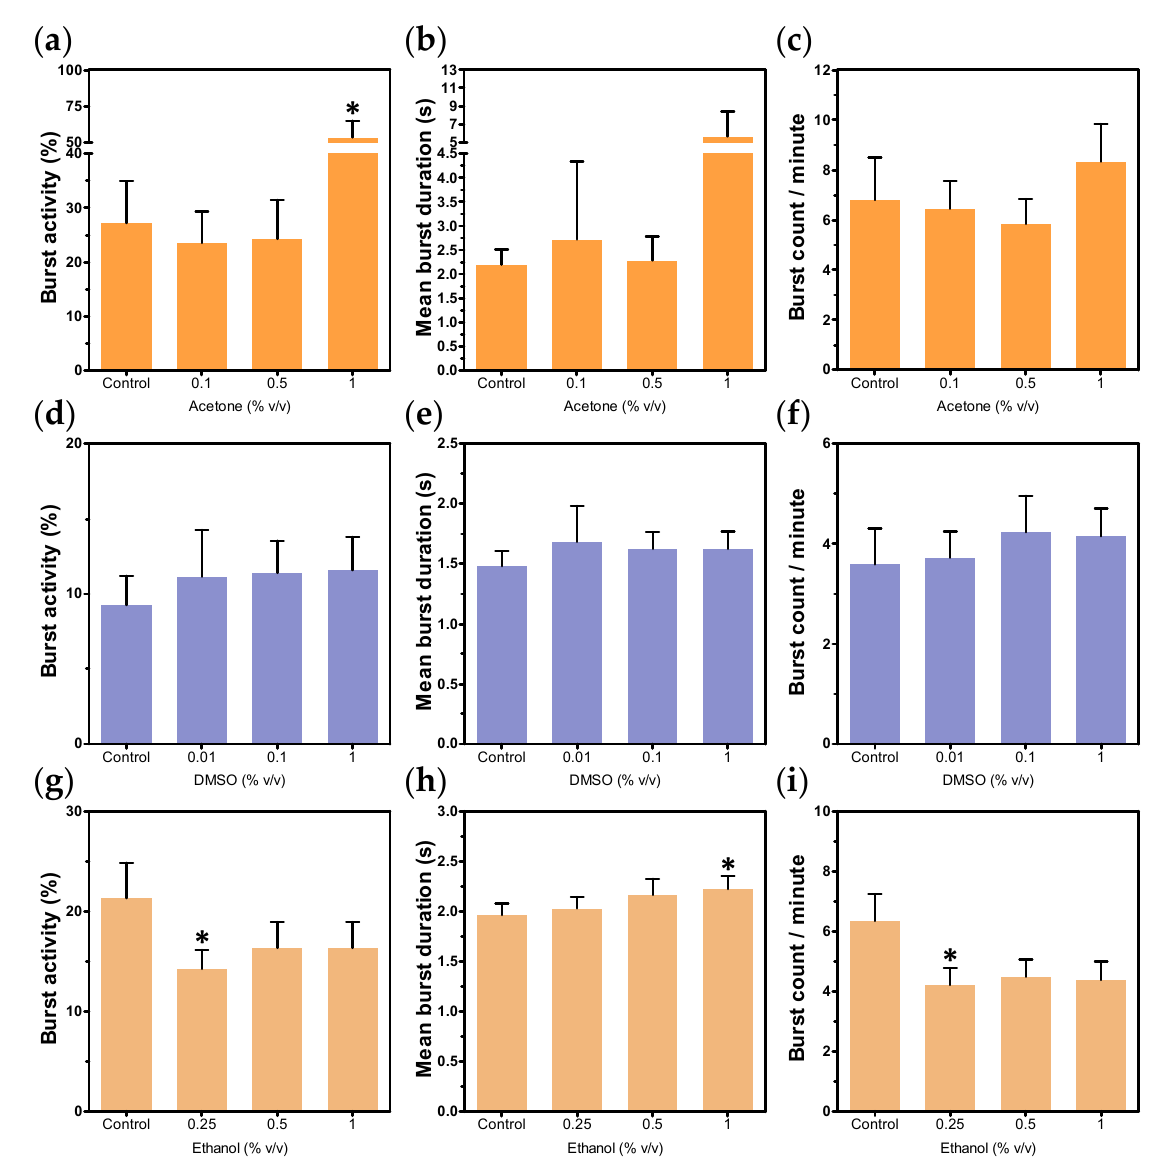
Figure 6. Coiling activity of zebrafish ( Danio rerio ) embryos aged 26.0–28.5 h post-fertilization (hpf) following exposure to organic solvents. ( a – c ) Acetone; ( d – f ) DMSO; ( g – i ) ethanol. Significant differences between control (embryo medium) and treatments were tested by ANOVA on ranks (Kruskal–Wallis test), followed by the Dunn’s post-hoc test (* p ≤ 0.05); n = 60 embryos per treatment, divided into three independent experiments. Values are expressed as means (bars) and 95% confidence intervals (error bars).